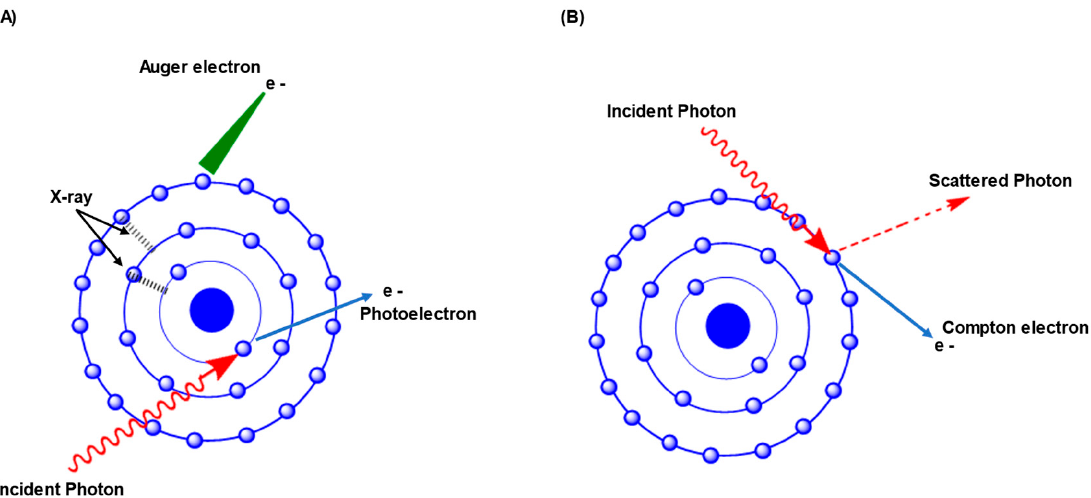
Figure 1. NP interaction with ionizing radiation. ( A ) The collision of incident photons with inner orbital electrons causes a photoelectric effect. The inner electron absorbs photon energy and ejects it as a photoelectron. Due to the ejection of photoelectrons, electrons from outer shell fill the gap resulting in the emitting of X-rays or the Auger electron. ( B ) On the other hand, the collision of incident photons with outer orbital electrons causes the Compton effect. The Compton electron absorbing photon energy is ejected from the atom, which may excite and ionize subsequent atoms. The photon loses a fraction of its energy and either continues on its course or is alternatively involved in further process, such as photoelectric effects or the Compton